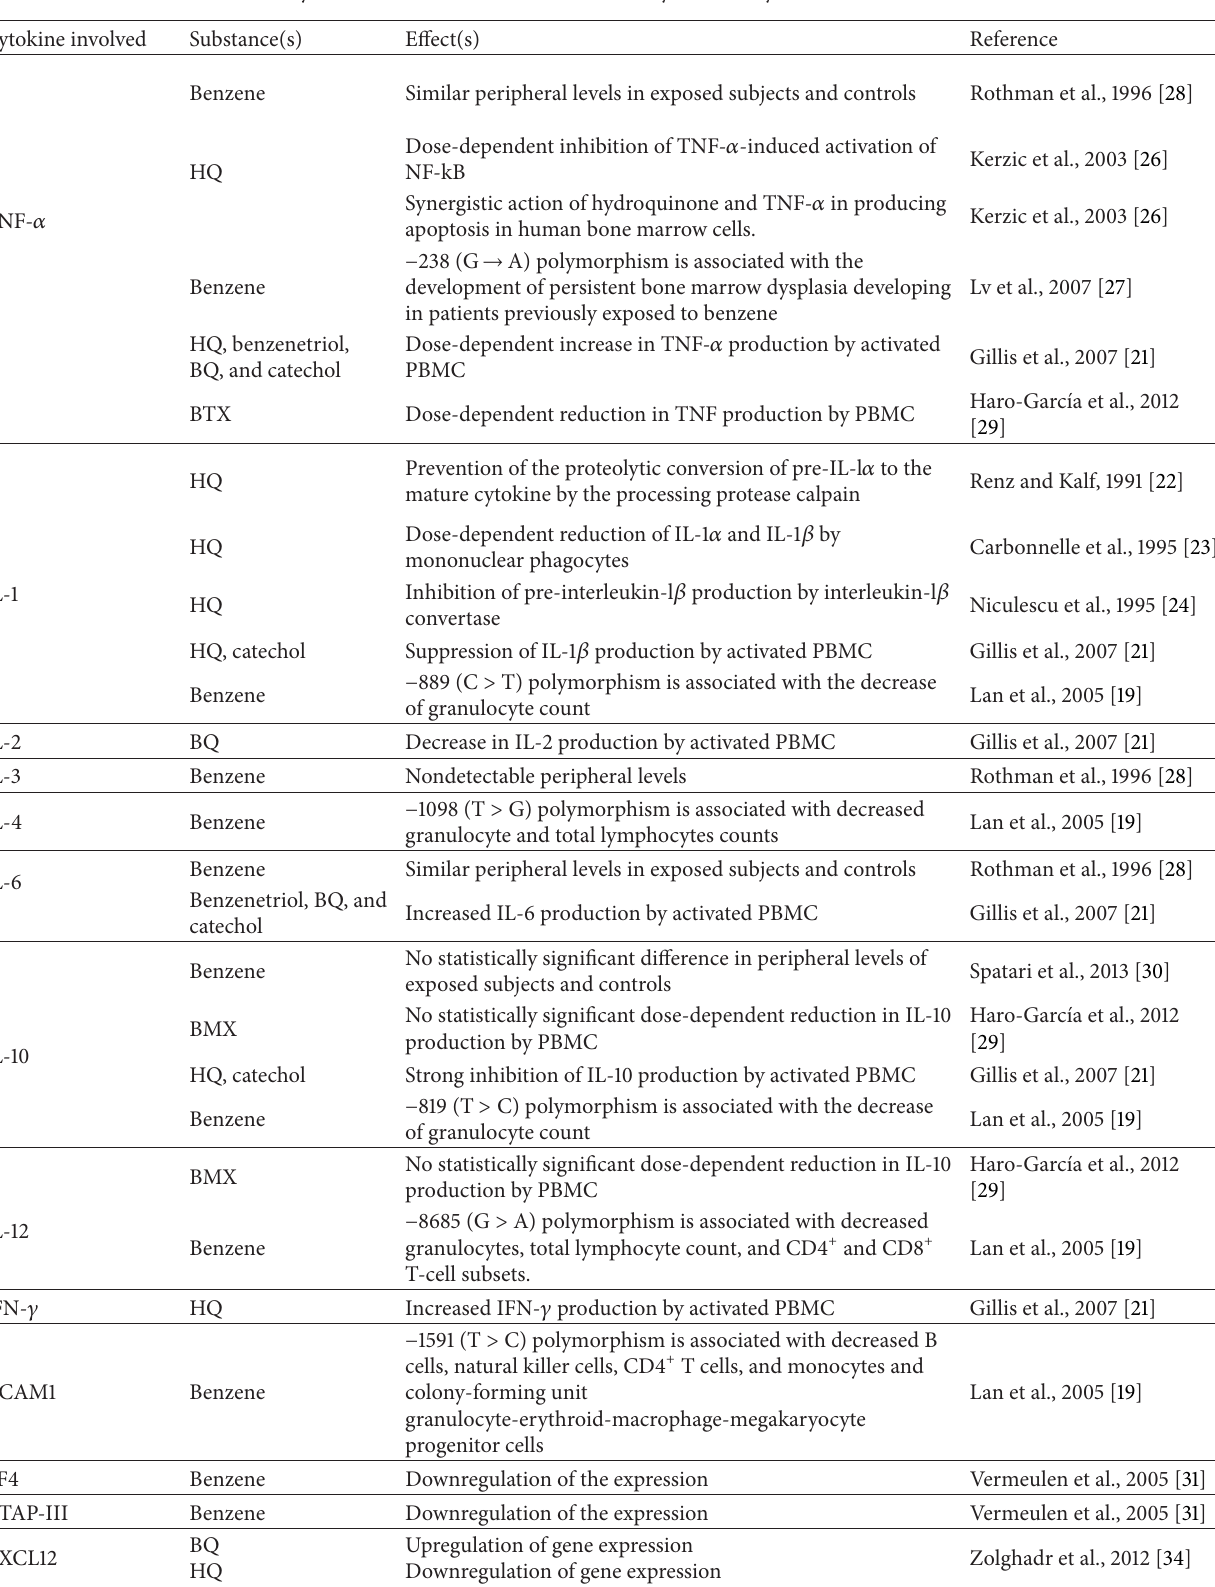
Table 1: Summary of considered studies on hematotoxicity induced by benzene and/or its metabolites. Cytokine